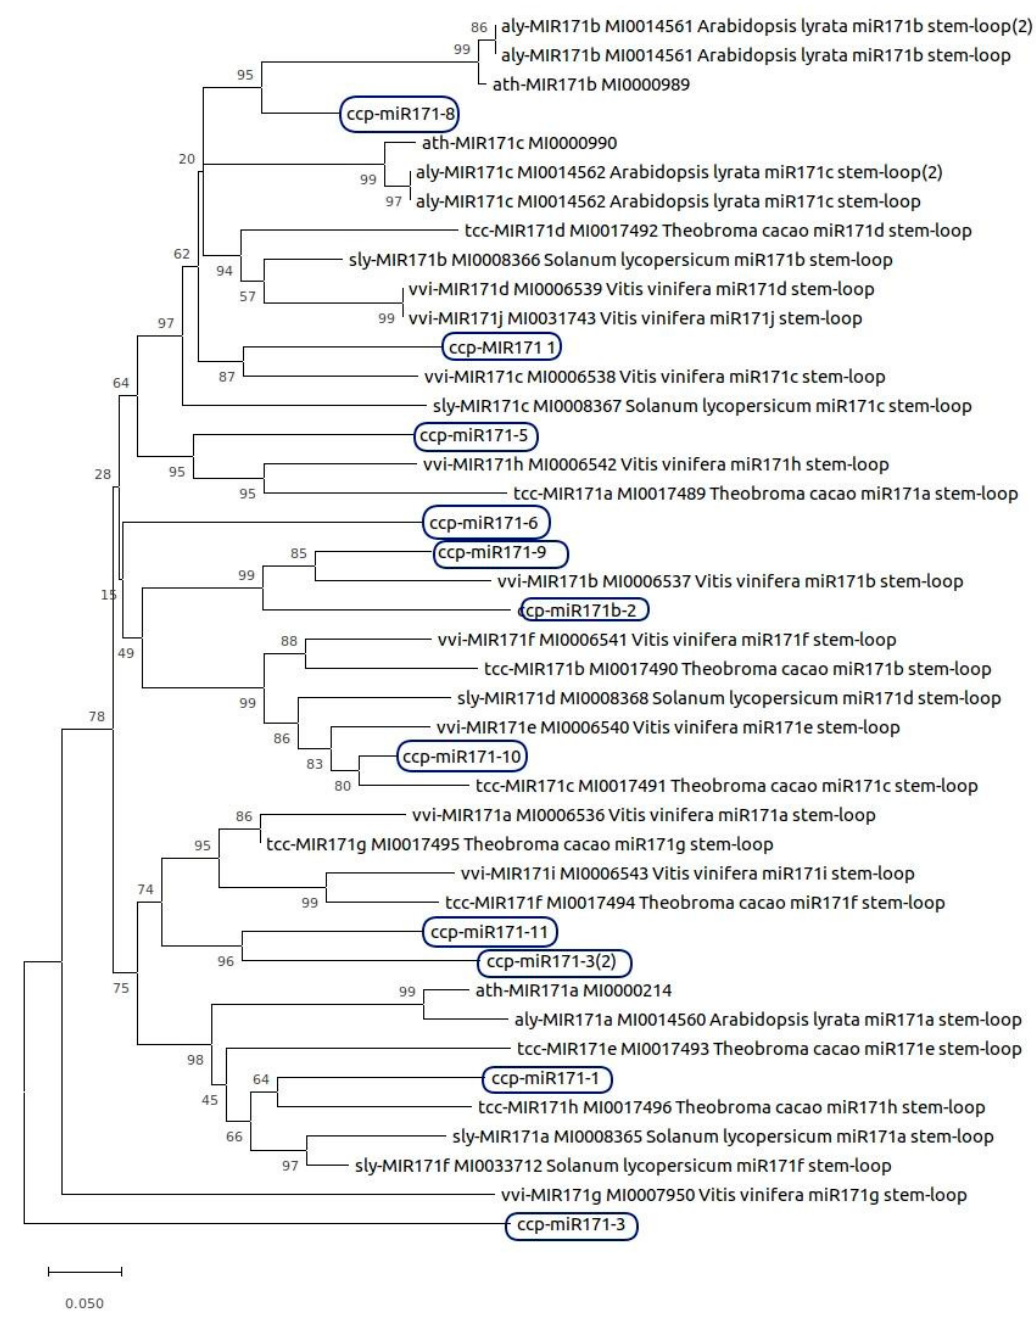
Figure 2. Phylogenetic analysis of miRNA family miR-171. The highlighted precursors showed high conservation among a total of 42 sequences, including their